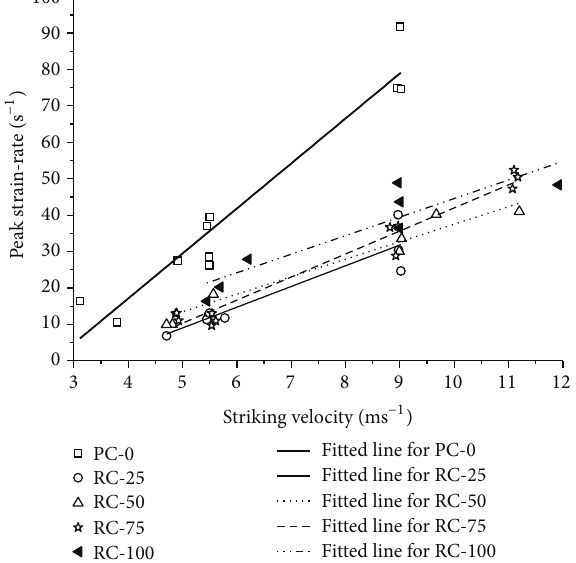
Fitted line for PC-0 Fitted line for RC-25 Fitted line for RC-50 Fitted line for RC-75 Fitted line for RC-100 Figure 5: Peak strain-rate versus striking velocity with fitted lines. waveforms of a natural aggregate concrete (NAC) specimen shaped by a brass pulse with diameter of 20 mm. It shows that the dispersion of strain pulse during SHPB test is eliminated by the use of this pulse